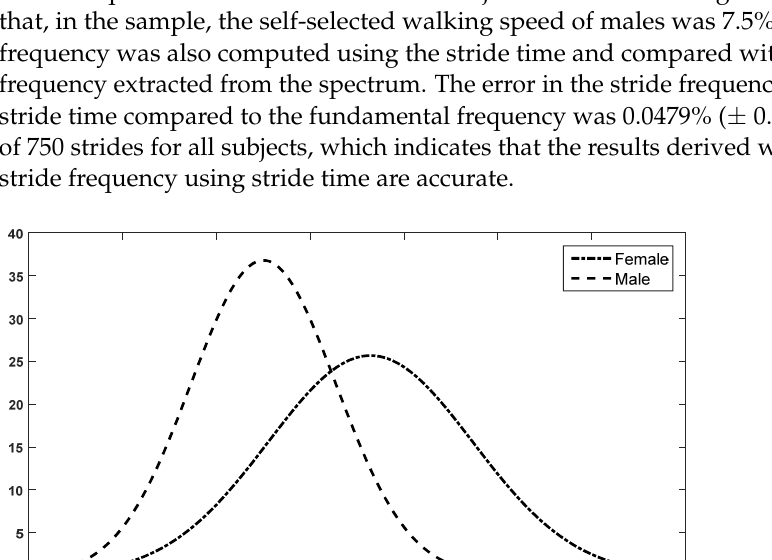
Figure 9. Distributions of initial phases of first five harmonics for all female and male trials.